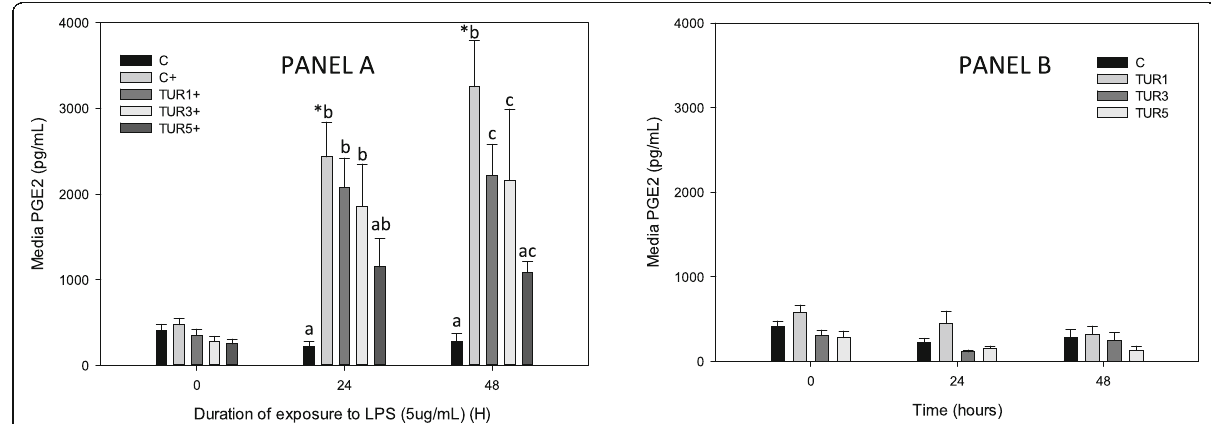
Fig. 1 PGE 2 production by cartilage explants ( n = 8 pigs) conditioned with simulated biological extract of turmeric (3, 9 or 15 μ g/mL; TUR1, TUR3 and TUR5 respectively) compared with simulated biological extract containing no turmeric (C) in the presence (Panel a ) or absence (Panel b ) of lipopolysaccharide (LPS; 5 μ g/mL) (+).Explants were cultured for a total of 96 h and were conditioned with TUR for the first 48 h prior to exposure to LPS. Data are shown for the final 48 h only. * denotes significant change from baseline within treatments. Letters denote significant differences between treatments at specific time